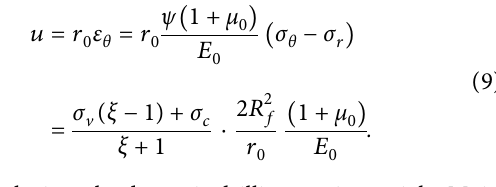
Figure 1: Stress zones in front of the working face.